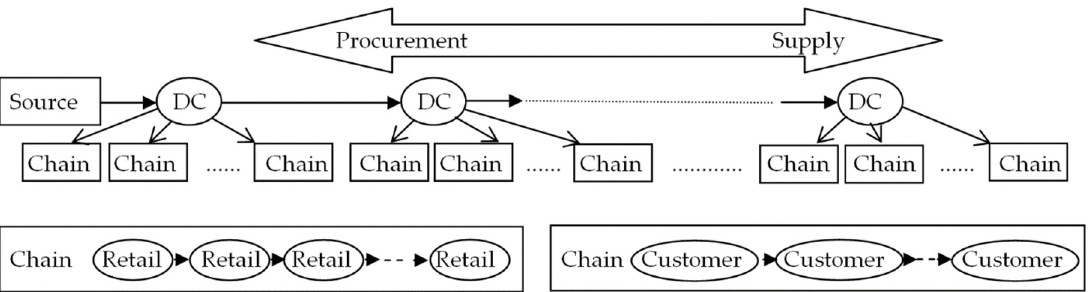
Figure 3. Individual spokes of a star topology within supply chains.